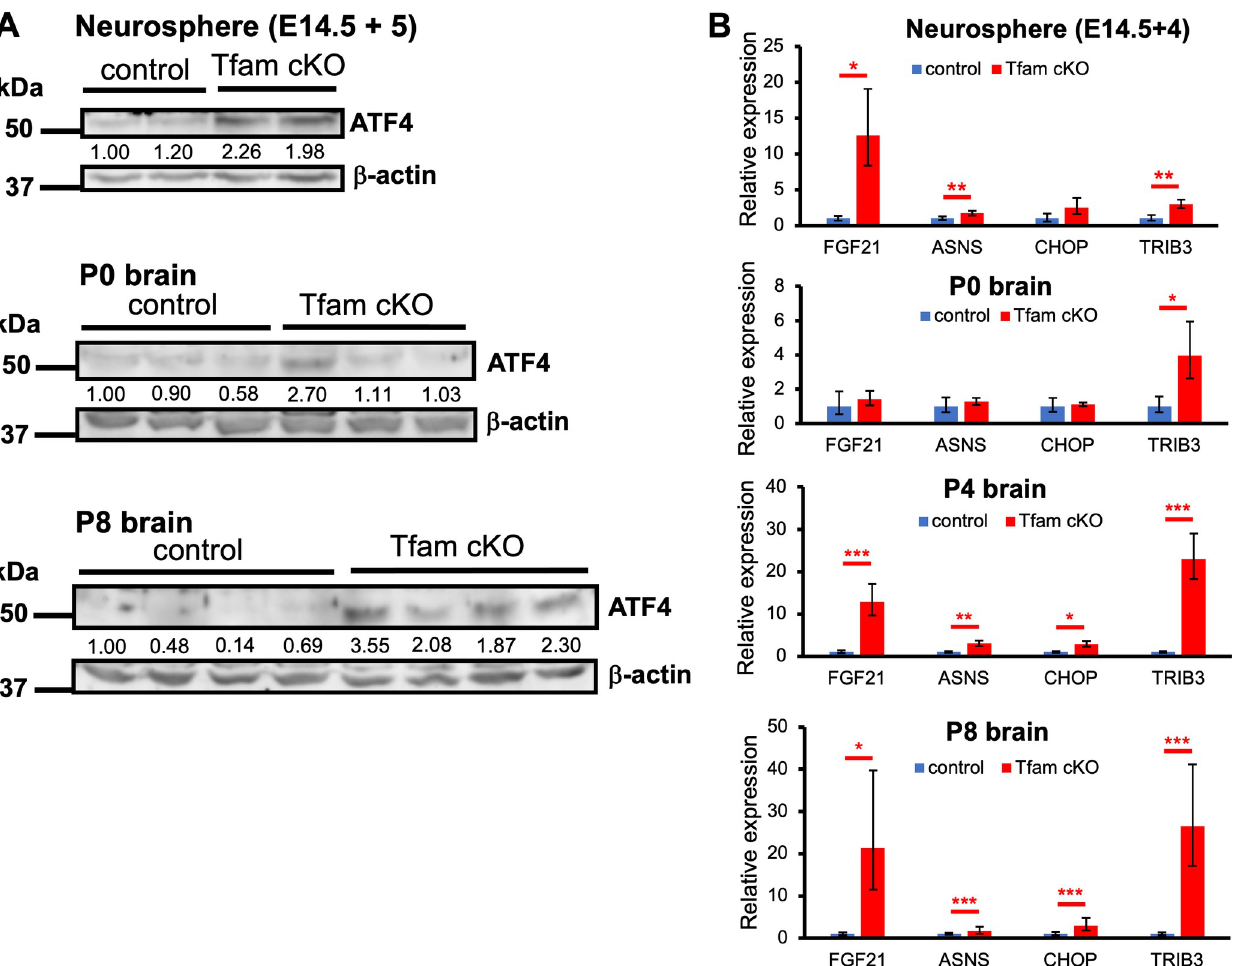
Fig 6. Activation of ISR in Tfam cKO brains and cultured NSCs. (A) Western blot analysis of ATF4 for cultured neurospheres (E14.5 + 5), P0, and P8 brains. Beta-actin was used as a loading control. (B) The expression of ATF4 target genes by qRT-PCR. Total RNA was isolated from neurospheres (E14.5 + 4), P0, P4, and P8 brains. The expression levels of each gene were normalized using β -actin. Graph shows means ± SD. n = 3 mice per group. � P < 0.05; �� P < 0.01; ��� P <